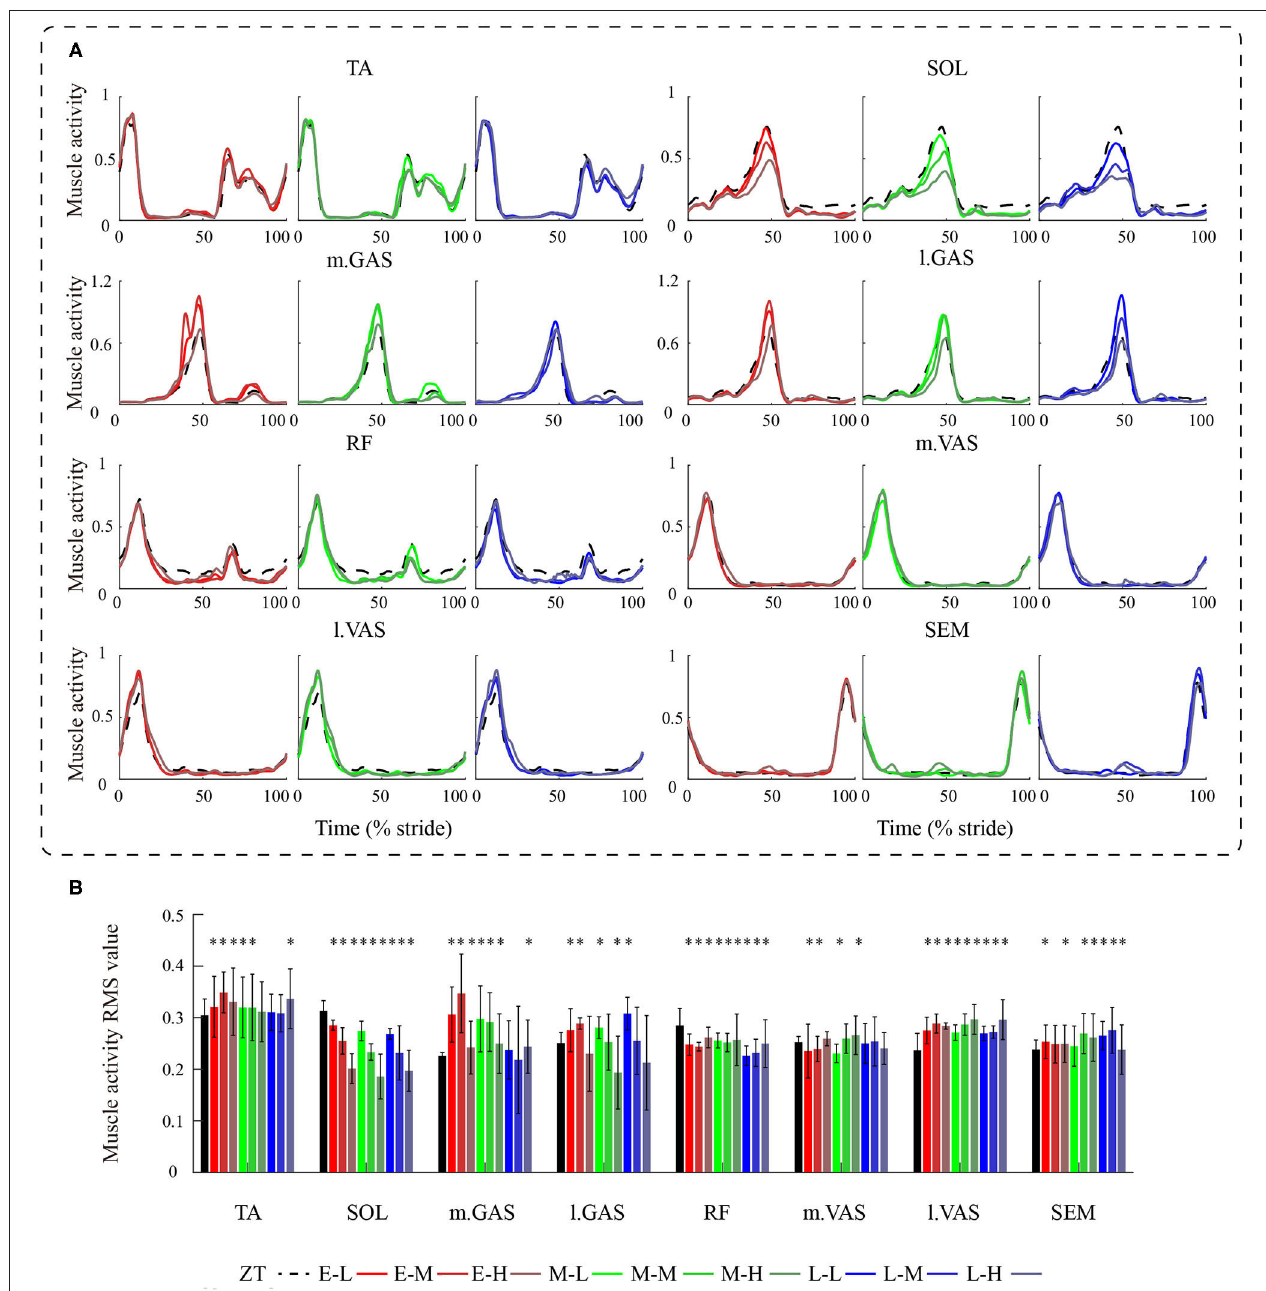
FIGURE 8 | (A) Exoskeleton-side lower limb muscle activities during human walking with different ankle exoskeleton assistance patterns. (B) Muscle activity RMS values in different walking conditions. *represents statistically significant differences with respect to the ZT condition.